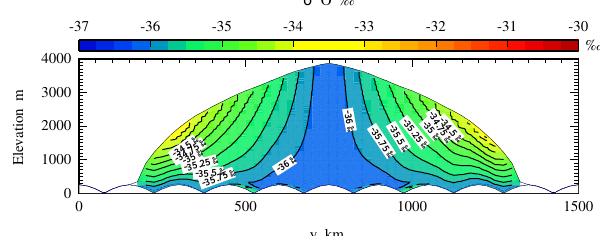
Figure 7. Cross section of the depositional provenance of x at time 300kyr with the mound topography and the dashed contour of the temperate ice thickness H t . The colour bar indicates the origin of the ice where blue for example means that the ice is coming from the x coordinate of 0km.